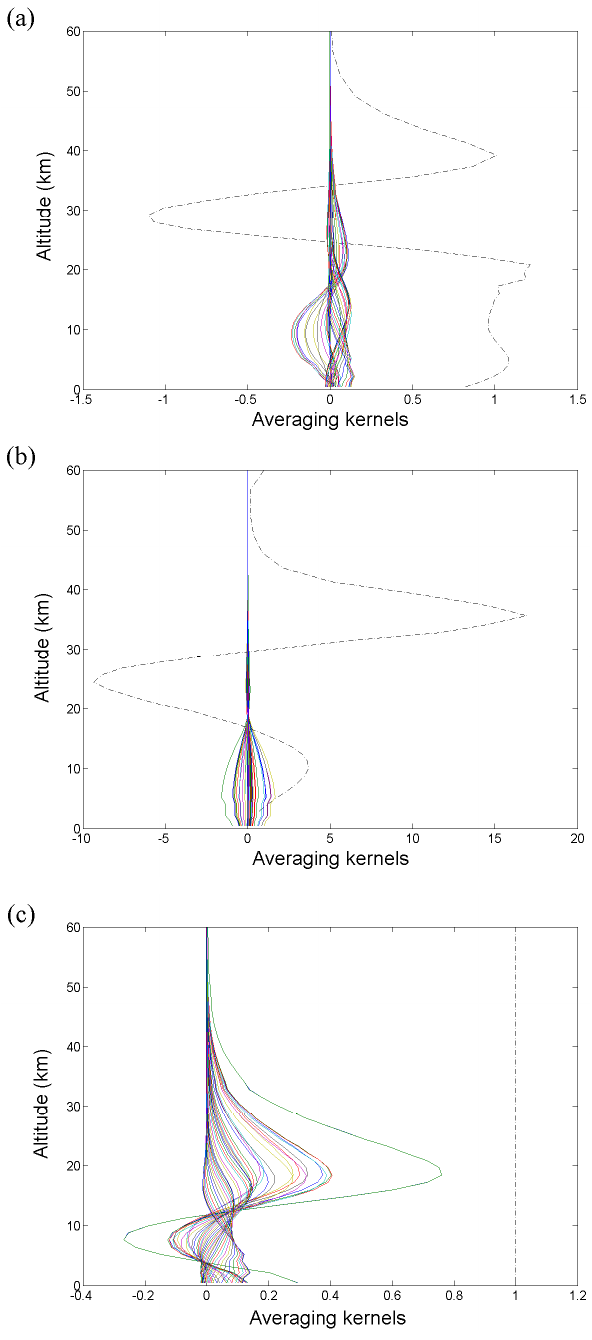
Fig. 8. Averaging kernels and sensitivity curve (black dashed) for the CH 4 retrieval from a single spectrum on 2 October 2007 at St.- Denis using the (a) OEM, (b) IOA and (c) TR.